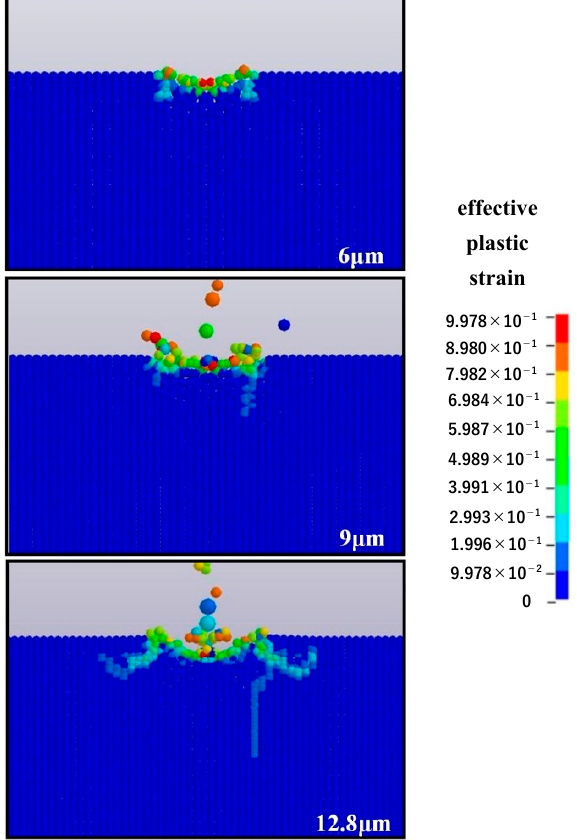
Figure 11. Surface morphology of impacted optical glass under different particle diameters.